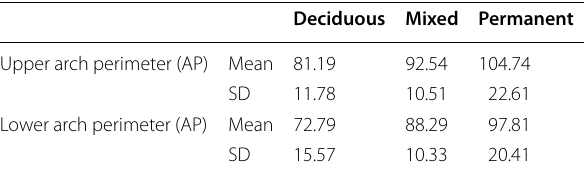
Table 3 Mean, standard deviation of arch perimeter in